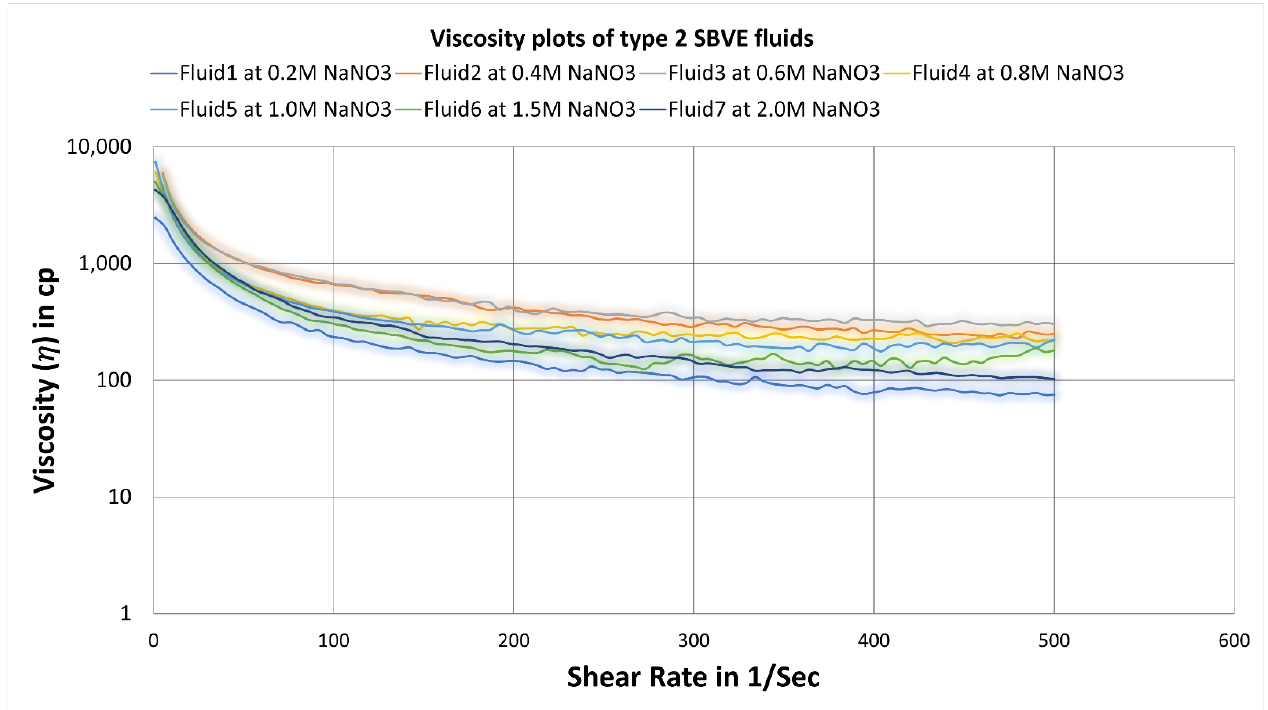
Figure 7. Viscosity curves for surfactant-based viscoelastic fluids of type2 with varying NaNO 3 concentrations at 25 °C. Please change the same as below.